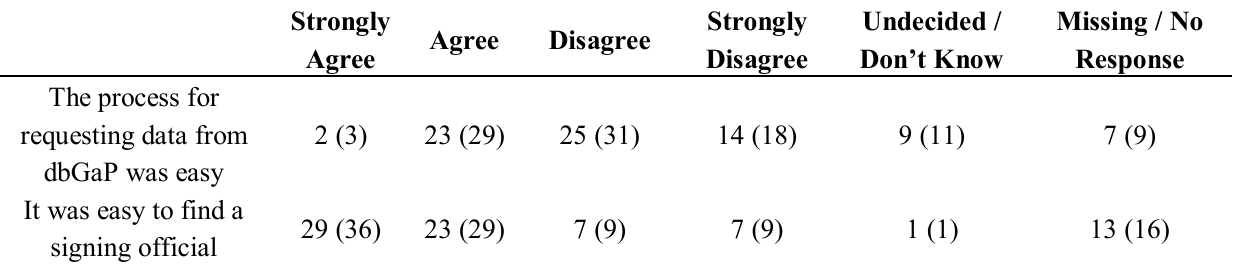
Table 3. Attitudes towards dbGaP access issues a,b .